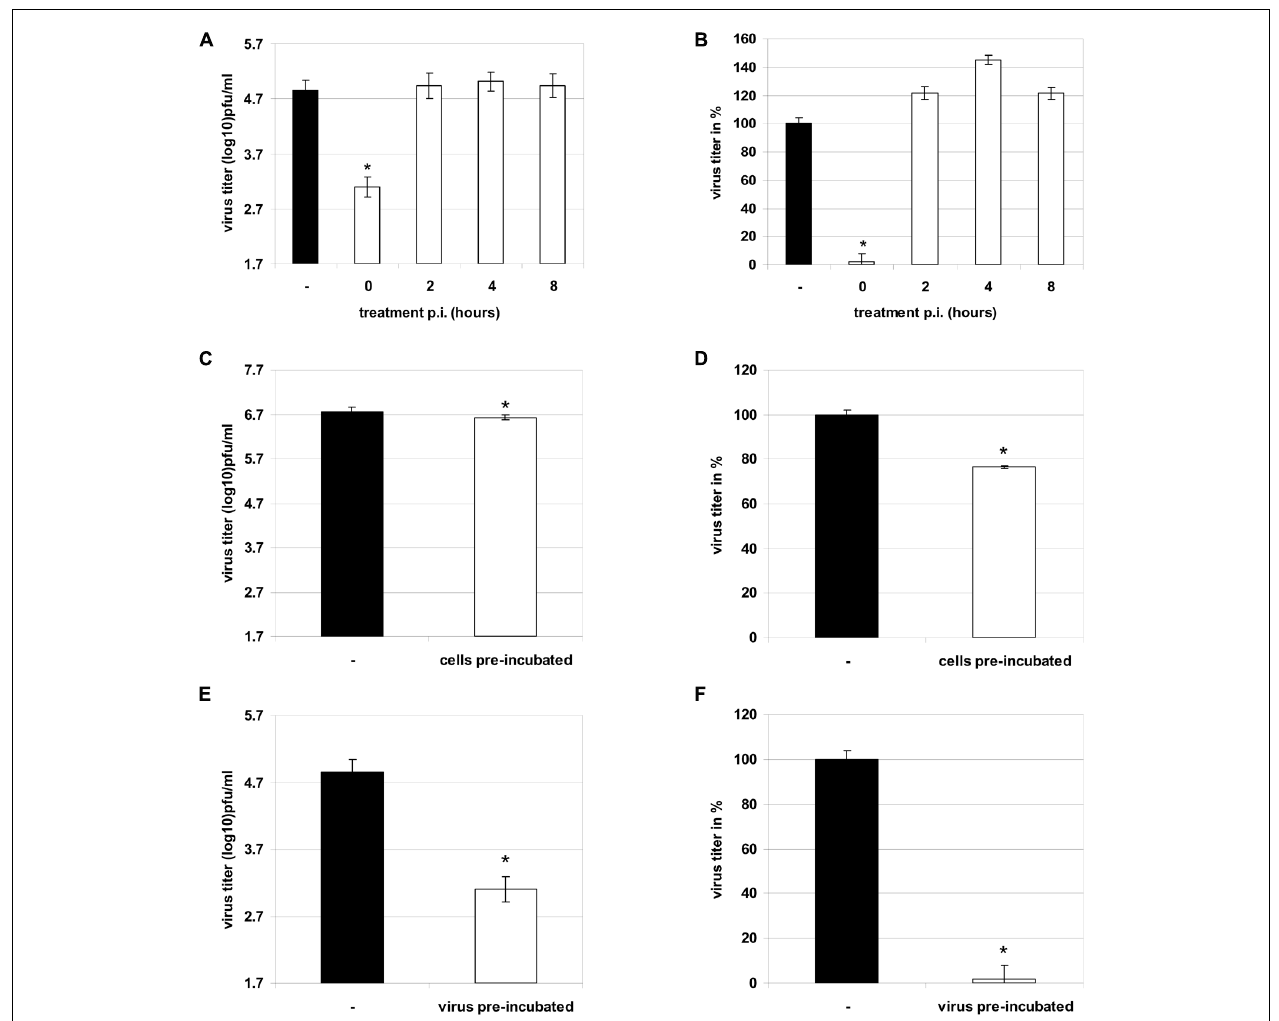
titer was measured by plaque assay ( C : in pfu/ml, D : in %). Prior to infection, virus was 2 h per-incubated with 100 μ g/ml Ladania067 or solvent at 37 ◦ C and 5% CO 2 . After incubation A549 cells were either infected with Ladania067-incubated or solvent-incubated virus for 24 h. After incubation progeny virus titer was measured by plaque assay ( E : in pfu/ml, F : in %). For calculation, the experiment was performed two times independently with each comprising triplicates (* p <